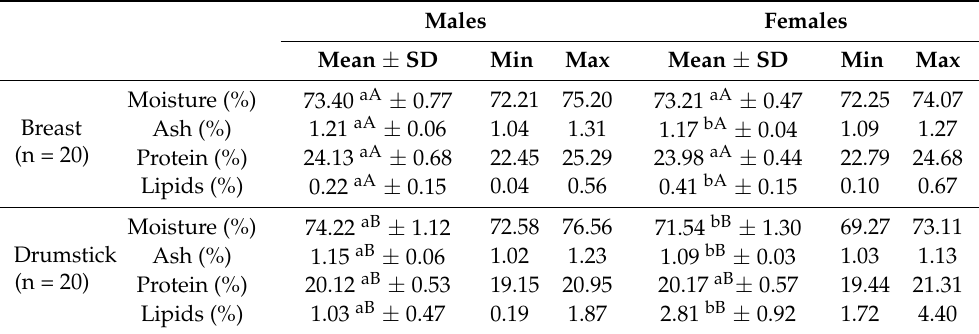
Table 3. Chemical composition of the breast and drumstick meat of males and females of the “Branca” breed (mean ± SD, Min and Max) (results expressed in % of fresh